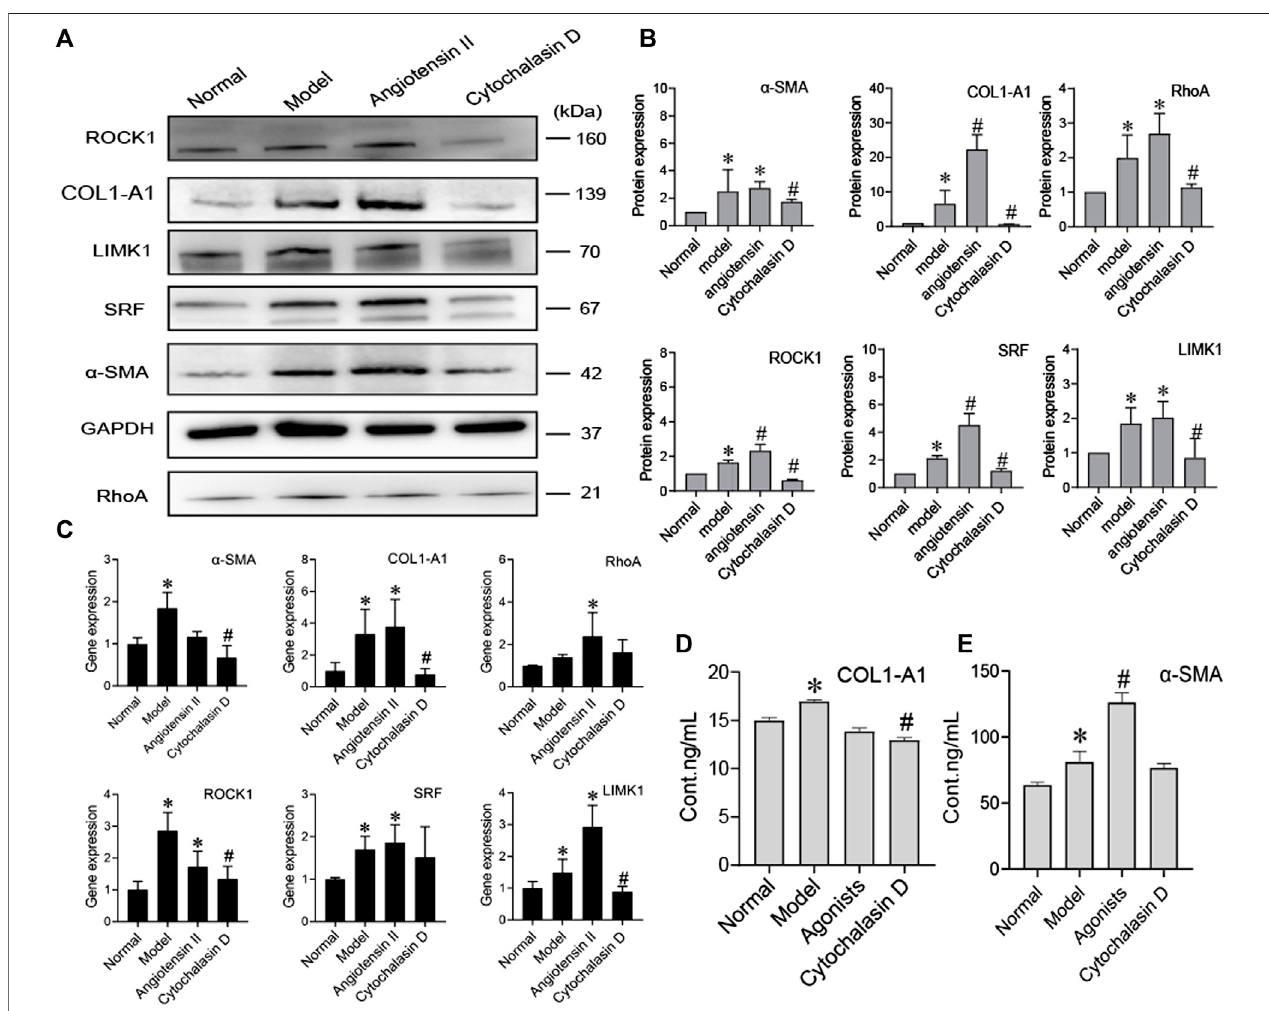
FIGURE 5 | BMSCs regulate the activation of HSCs by inhibiting cytoskeletal rearrangement. (A , B) Western blot bands and cumulative densitometric analyses of each group(normal,model, angiotensin II,cytochalasin D).Dataarepresented asthe mean±SEM( n =3independent experiments, one-wayANOVA; * p < 0.05, versus the normal group; # p < 0.05, versus the model group); (C) qRT-PCR analysis for α -SMA, COL1-A1, ROCK1, RhoA, SRF, and LIMK1 in HSCs. ( n = 3 independent experiments,one-wayANOVA;* p < 0.05versusnormal;# p < 0.05versusmodel); (D , E) Theproteincontentof α -SMAandCOL1-A1inextracellularmedium. n =3 independent experiments, one-way ANOVA; * p < 0.05 versus the normal group; # p < 0.05 versus the model